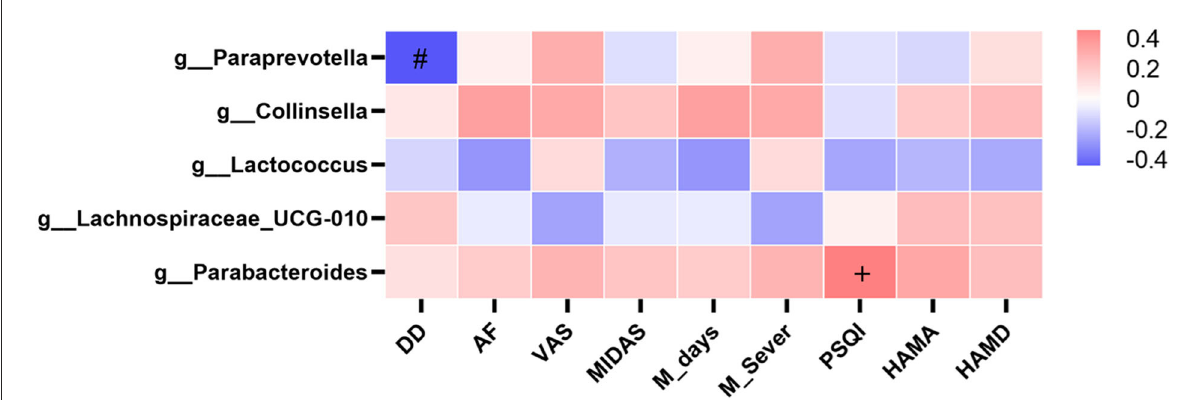
FIGURE5 Heatmaps showing correlations between gut microbiota and clinical characteristics of migraine. Heatmap based on the abundance (sequence counts) of gut microbiota (prevalence ≥ 10% in migraine patients with IBS) shows the correlations between significantly different taxa at the genus level and migraine clinical characteristics, including AF, DD, VAS, MIDAS, M_days, M_Sever, PSQI, HAMA, and HAMD. The intensity of the color represents the r value (correlation coefficient; negative score: blue; positive score: red). IBS, irritable bowel syndrome; AF, attack frequency; DD, disease duration; VAS, visual analog scale; MIDAS, the migraine disability assessment; M_days, MIDAS days; M_Sever, MIDAS severity; PSQI, Pittsburgh Sleep Quality Index; HAMA, Hamilton Anxiety Scale; HAMD, Hamilton Depression Scale. Spearman test, + P = 0.056 in positive correlation, # P = 0.075 in negative